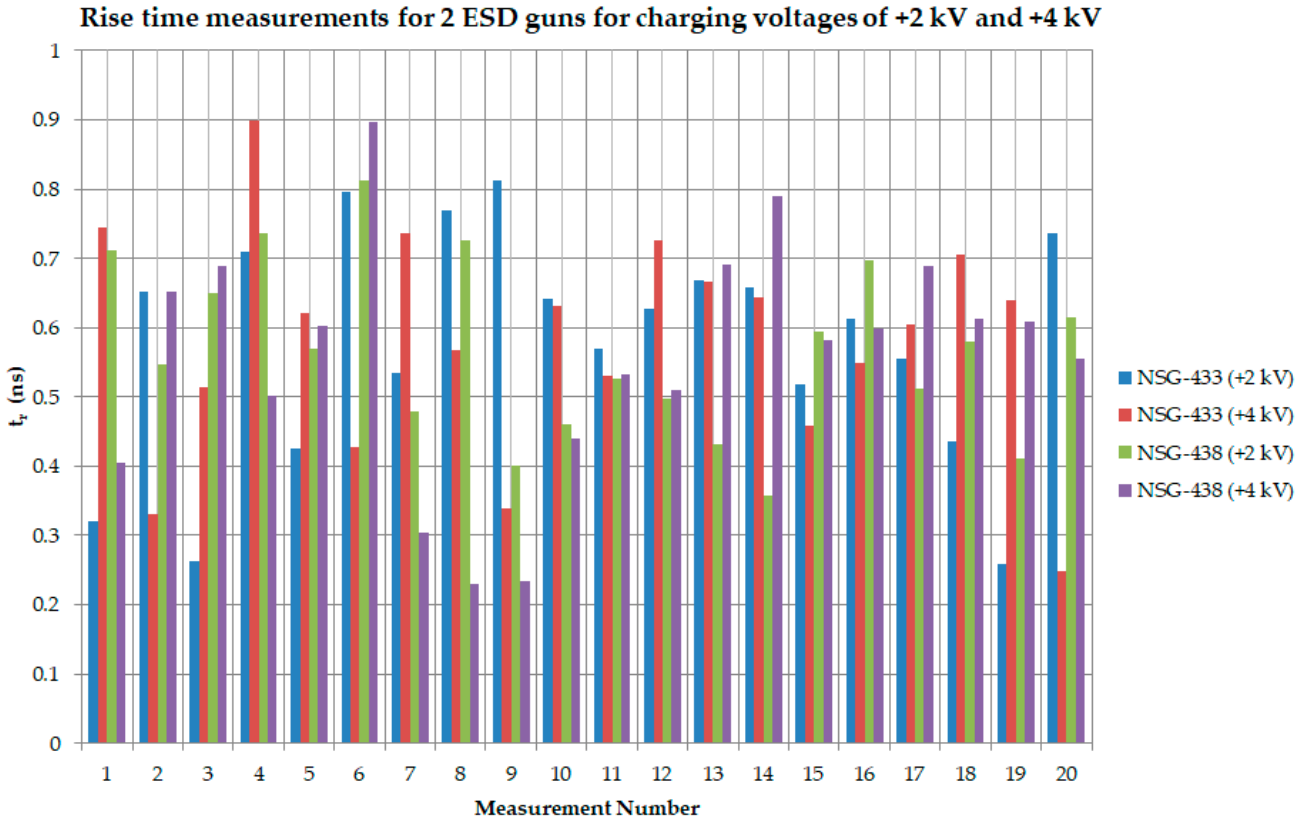
age values, the standard deviation and the uncertainty (type A) of these measurements are also included.